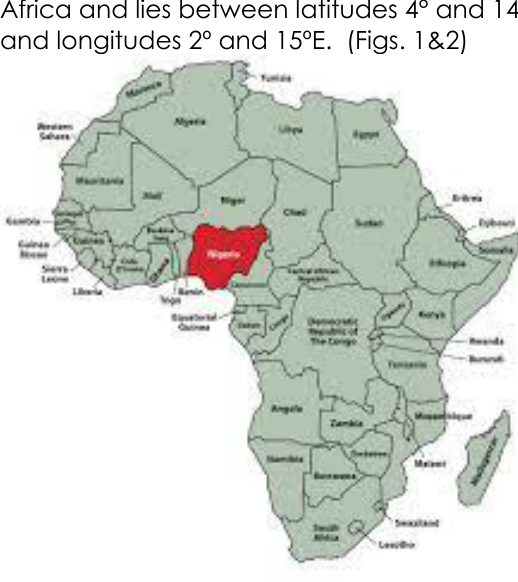
Figure 1. Map of Africa Showing Nigeria in Red. (Source: www.google.com)